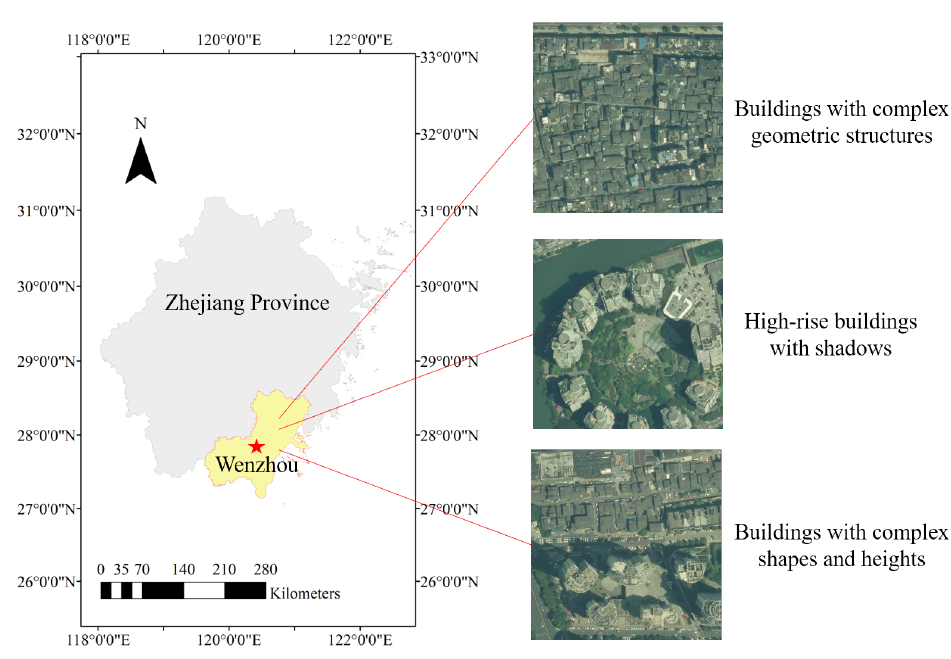
Figure 2. Location and diversity of buildings in the study